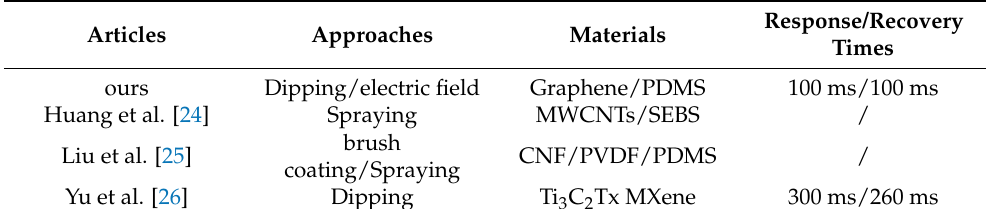
Table 1. Comparison between our work and related reported research.